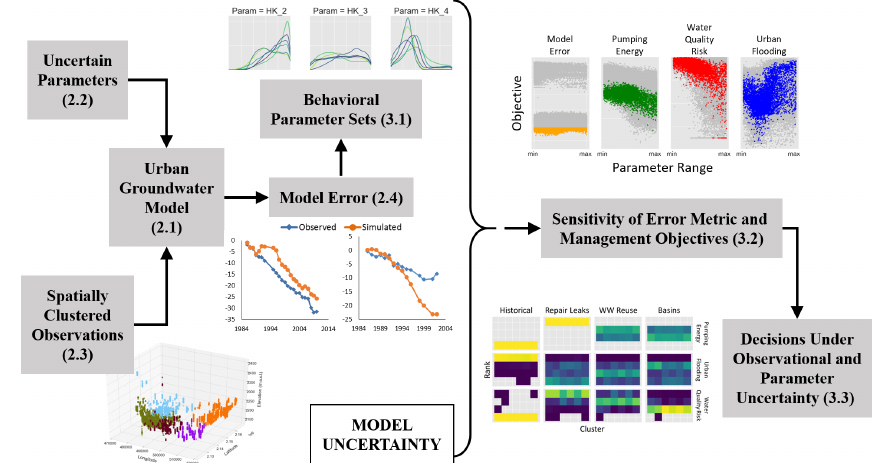
Figure 1. Flowchart of